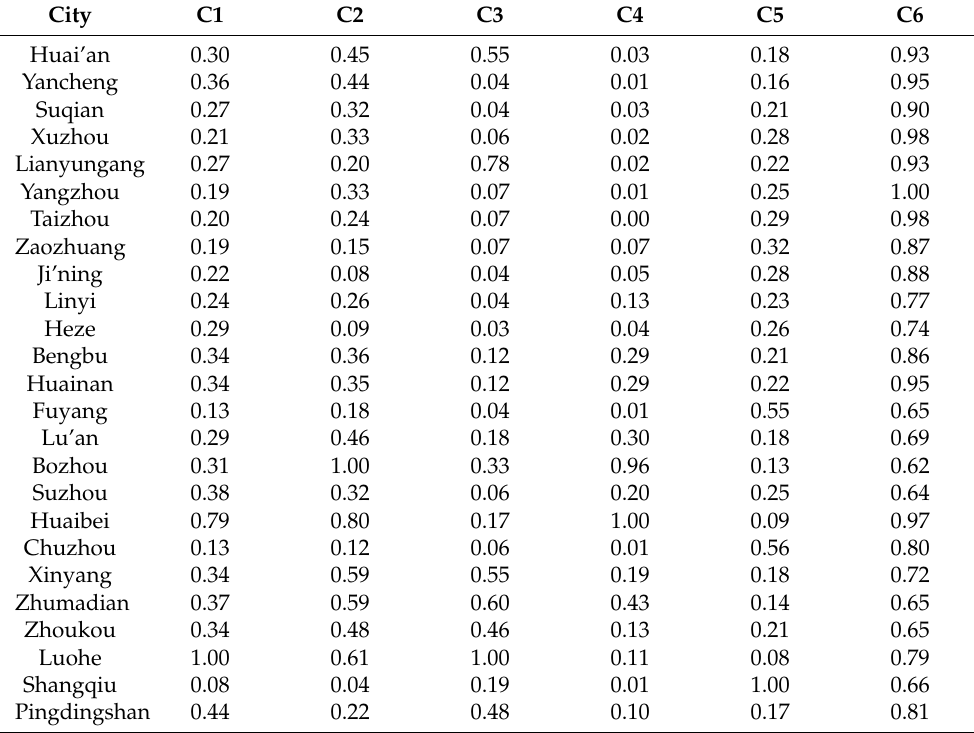
Table A2. Standardized results of the evaluation indexes of resource and environment carrying capacity.